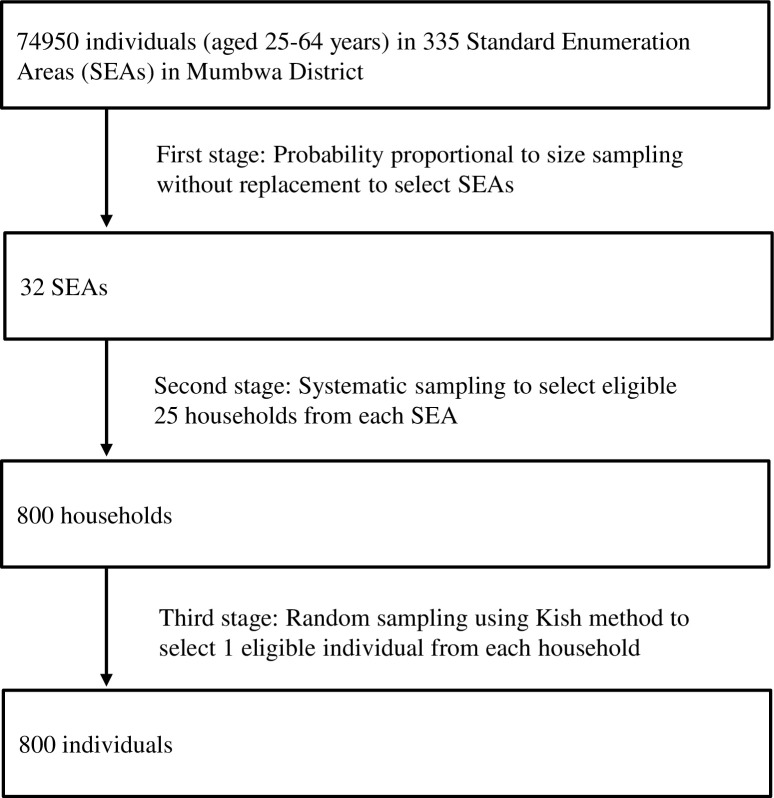
Sampling procedure according to probability proportional to size method.